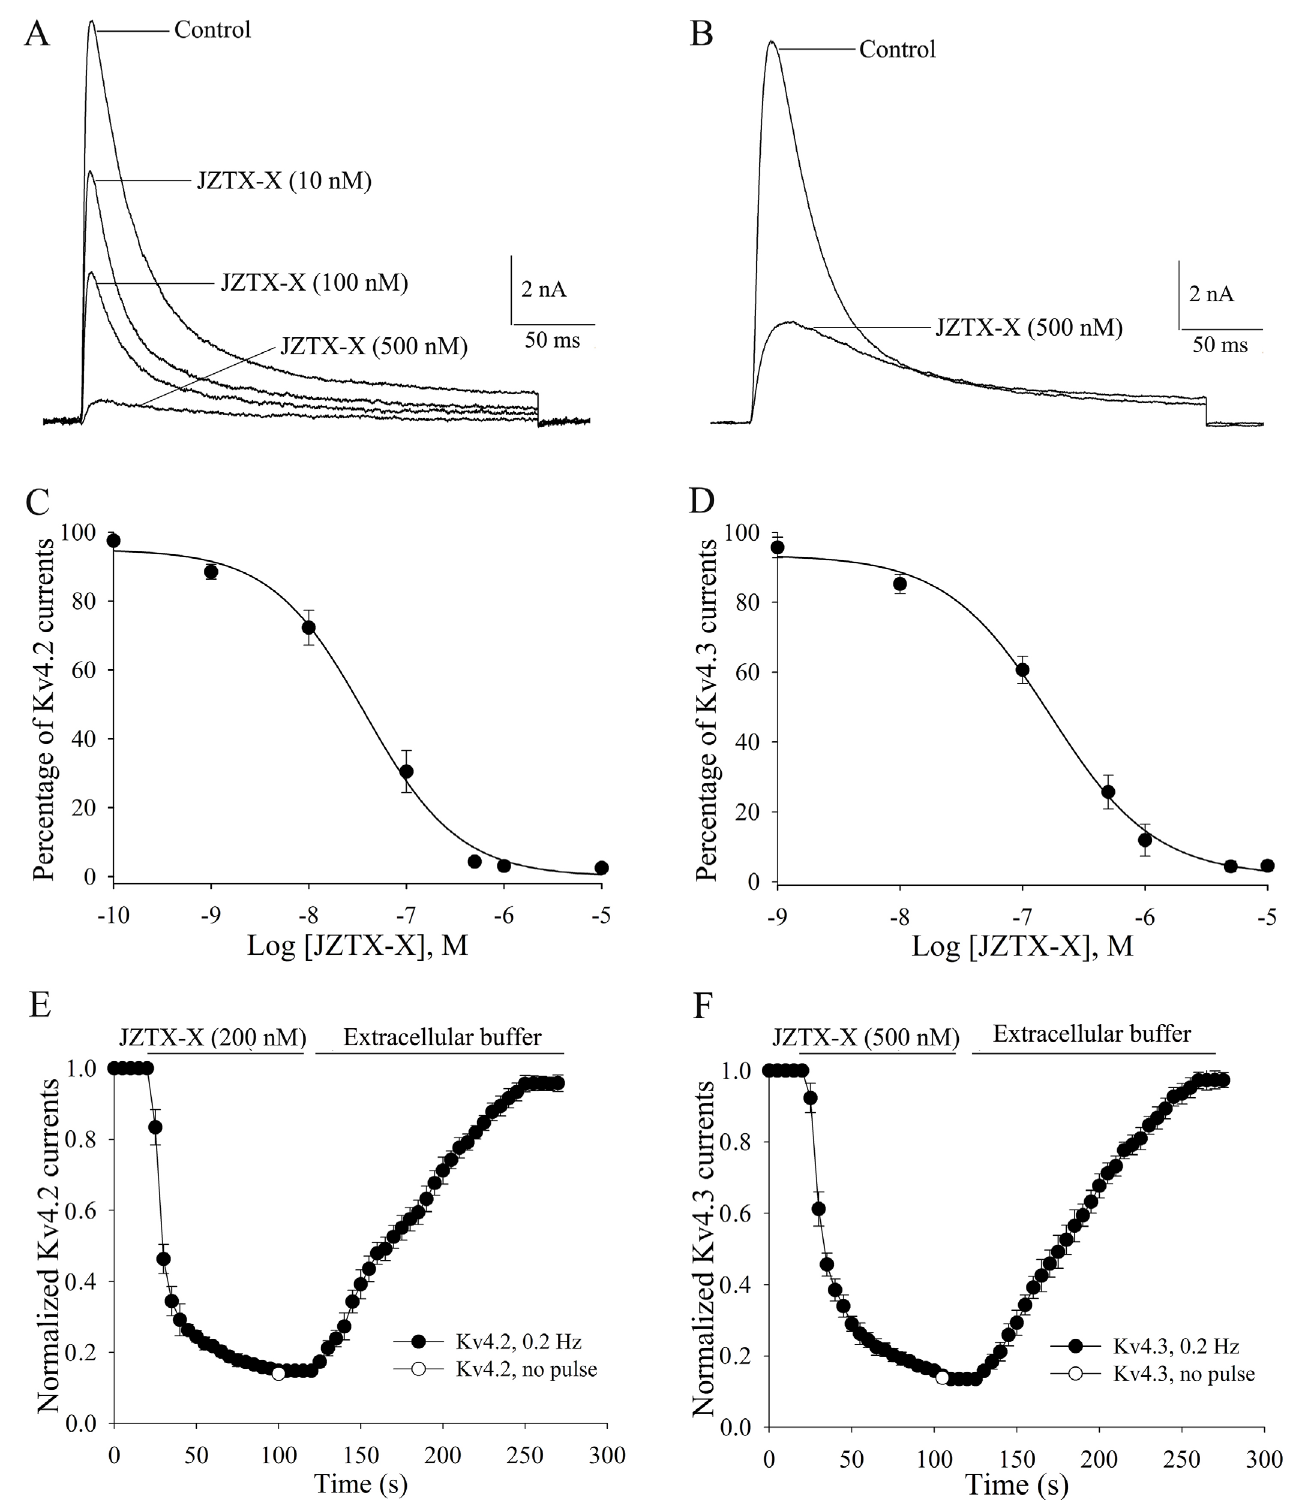
Figure 4. Effects of JZTX-X on Kv4.2 and Kv4.3 channels depending on dose and time: (A, B) original recording traces showed the effect of JZTX-X on Kv4.2 (A) and Kv4.3 (B) channels in HEK 293T cells. (C, D) Concentration-dependent suppression of Kv4.2 (C) and Kv4.3 (D) channels by JZTX-X in HEK 293T cells held at the voltage of −80 mV. All data (mean ± S.E.) were obtained from 5-8 independent experimental cells, and fitted based on Eq. (1) (“Materials and methods”). (E, F) The off- and on-rates of Kv 4.2 (E) or Kv4.3 (F) channels after 1 μM or 10 μM JZTX-X treatment, and were washed with a toxin-free external solution ( n = 6): No pulse suggested no pulse applied in Kv 4.2 (E) or Kv4.3 (F) channels (open circle) during the initial 100 s after toxin treatment. All data were expressed as mean ± S.E.M. and fitted based on Eqs. (2) and